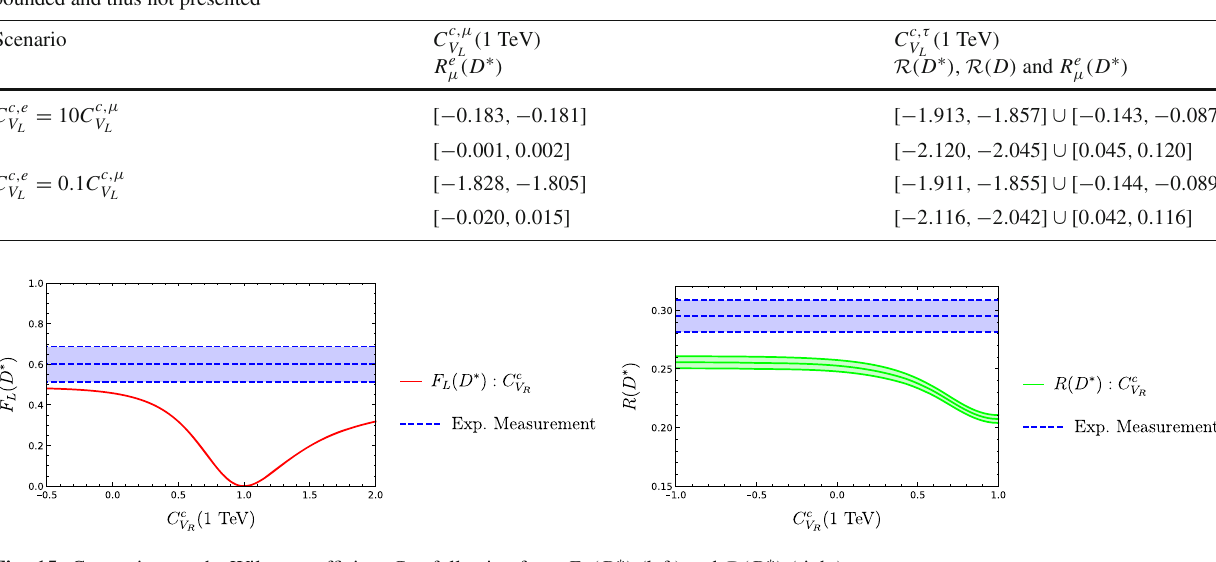
= C c ,μ the allowed NP regions are not V L V L